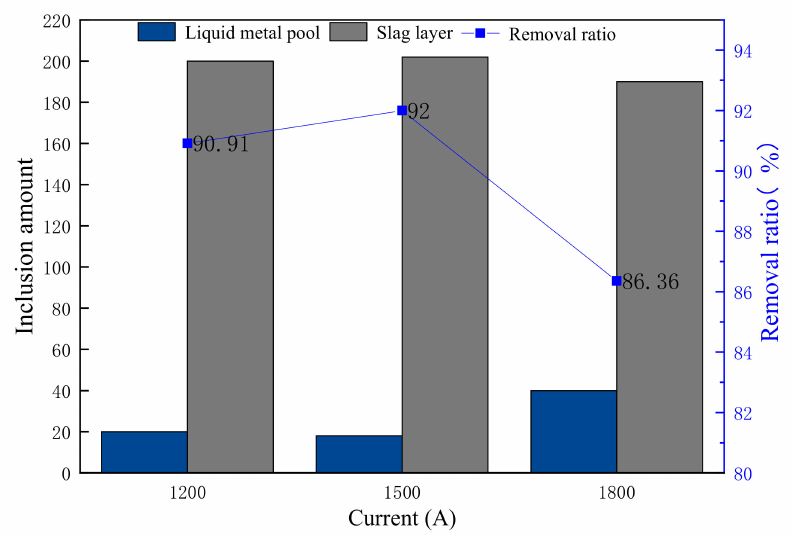
Figure 10. Comparison of removal ratio with different